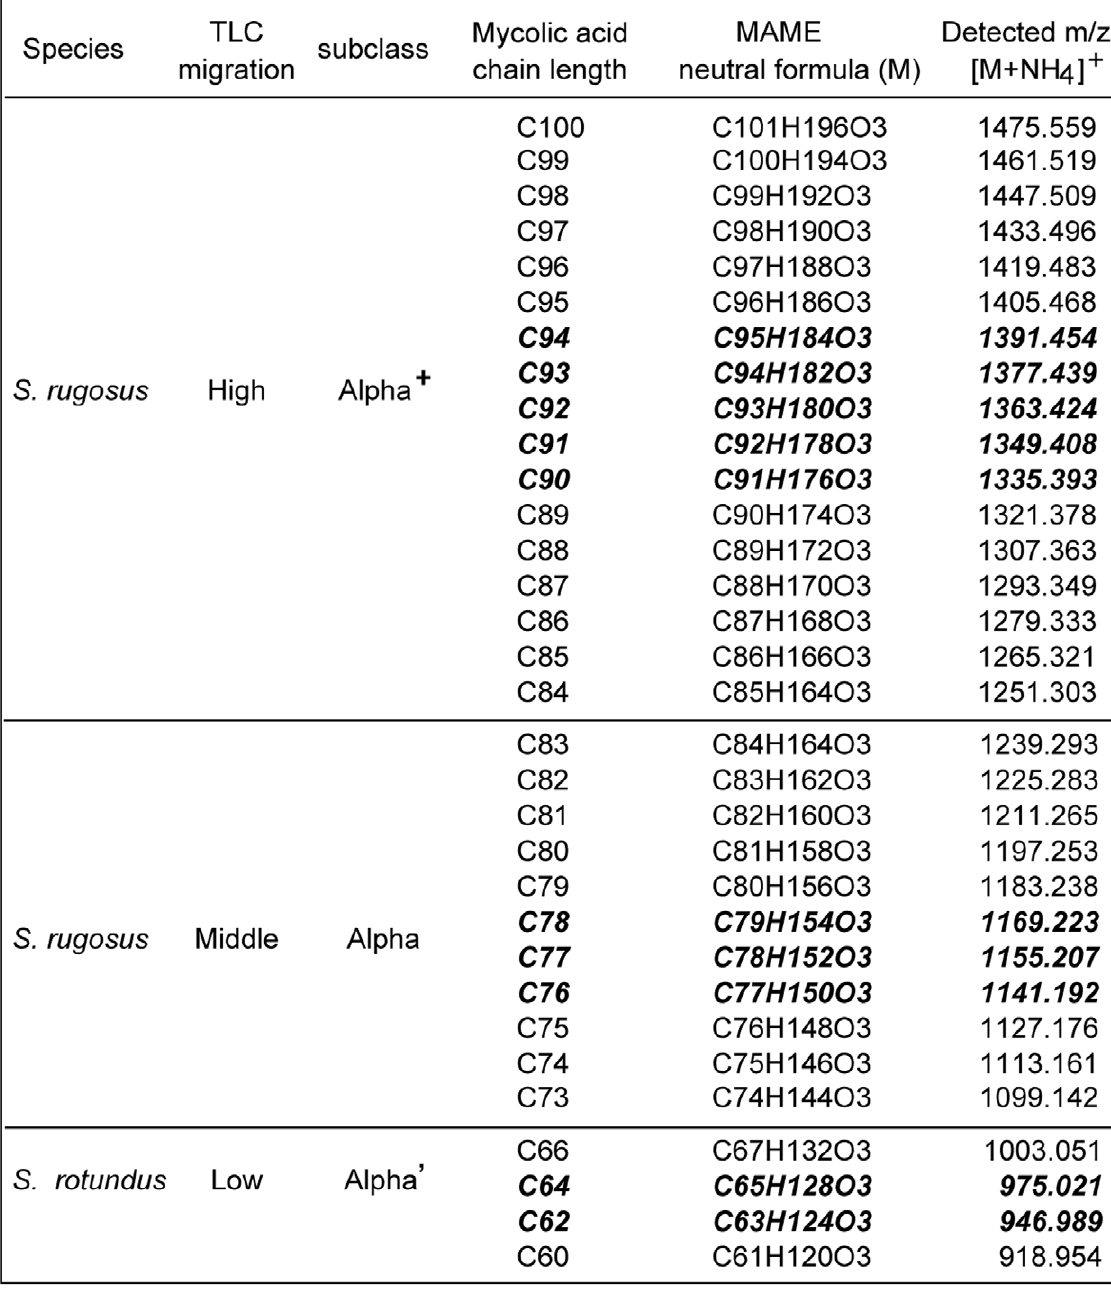
Figure 3. a + , a , and a ’ mycolates. Positive-ion mode Q-Tof mass spectrometry of 1D TLC purified MAMEs derived from S. rugosus (high and middle bands) or S. rotundus (low band). The high migrating MAMEs with longer chain length, the middle migrating MAMEs with medium chain length, or the low migration MAMEs with shorter chain length were initially designated as a + , a , or a ’ mycolate subclasses, respectively. The most intense molecular ions, observed here as ammonium adducts, present in each subclass are indicated in bold and italics.